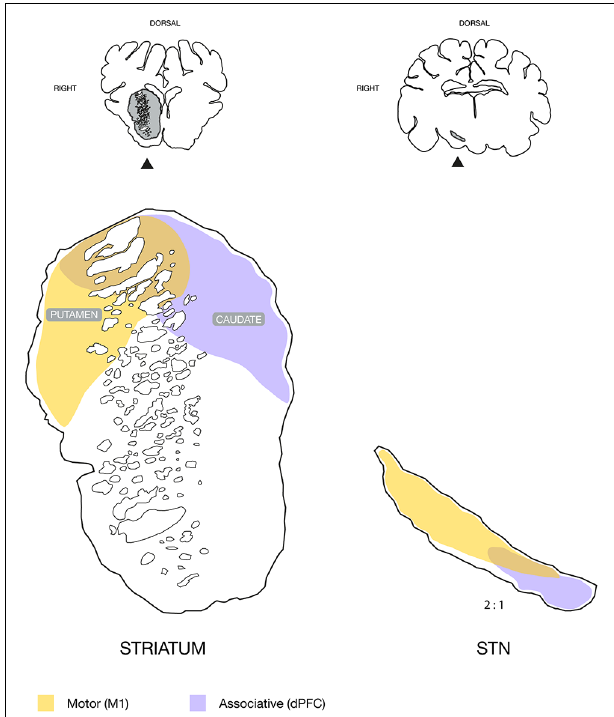
FIGURE 5 | Schematic illustration of the topography found in the striatum and subthalamic nucleus (STN), with neuronal tracing. Motor input domains were labeled by the approximated combination of neuronal tracing patterns from animals injected in the primary motor cortex, M1. The associative domain represents the animal injected in the dorsal prefrontal cortex, dPFC. Coronal sections are illustrated above for overview with the striatum and STN marked in gray and with an arrow. Note that the STN is displayed in twice its size relative to the striatum for illustrative